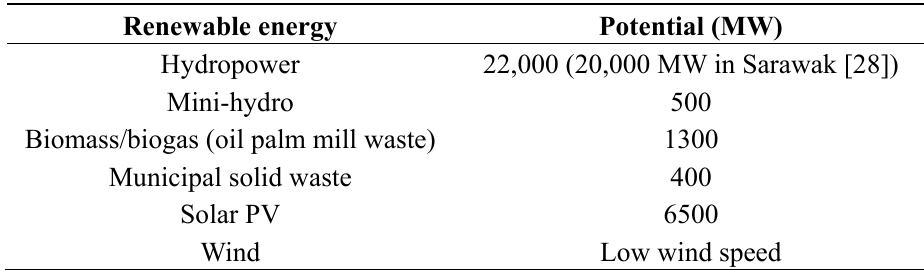
Table 8. Renewable energy potential in Malaysia